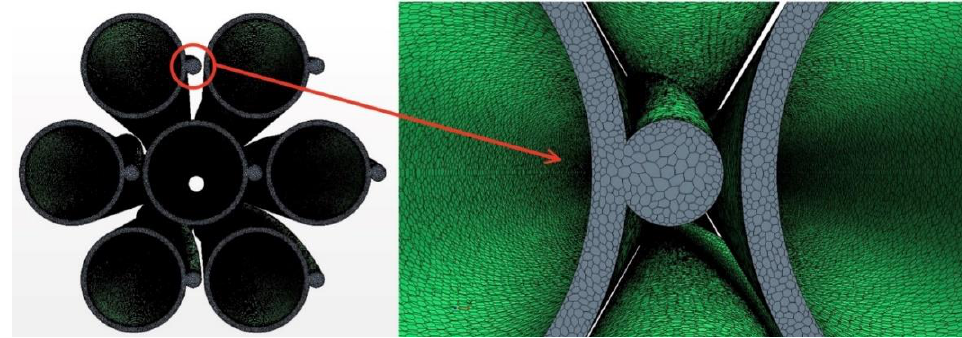
Figure 4. The meshes between wire and rod.